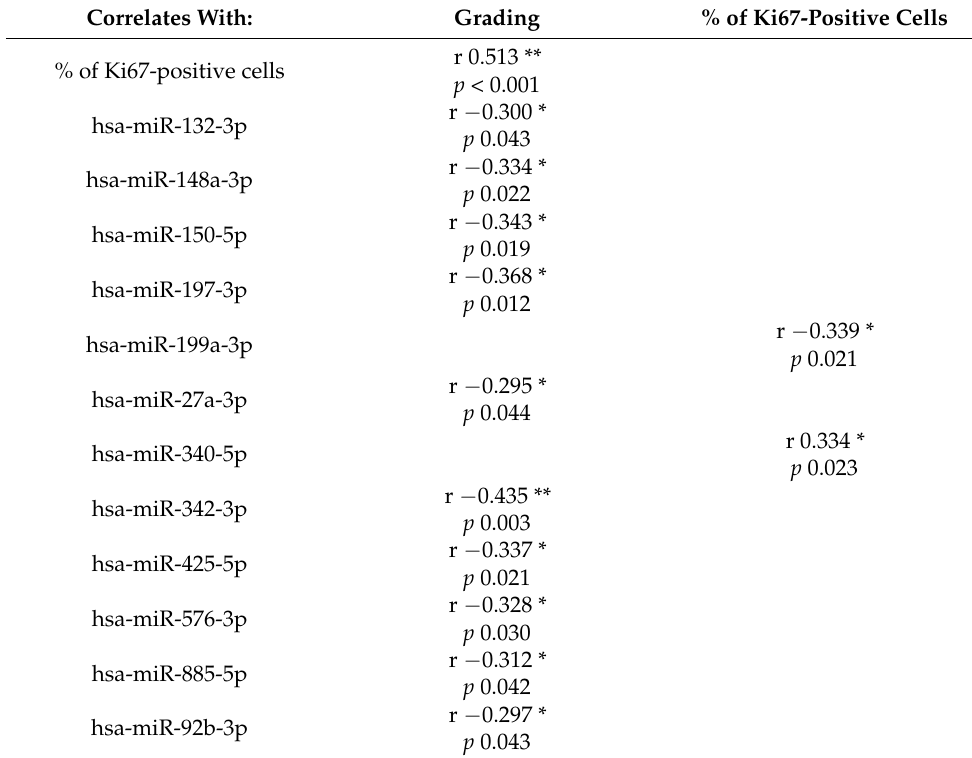
Table 2. Correlation analysis of miR expression and tumor